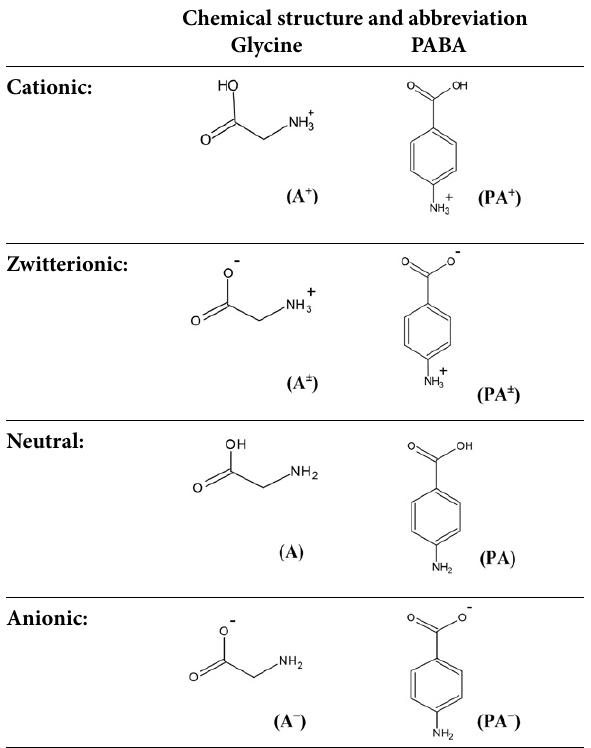
Table 1. Zwitterionic, cationic and anionic chemical structures of Glycine pK1 = 2.35, pK2 = 9.77, pI = 6.06)and p-amino